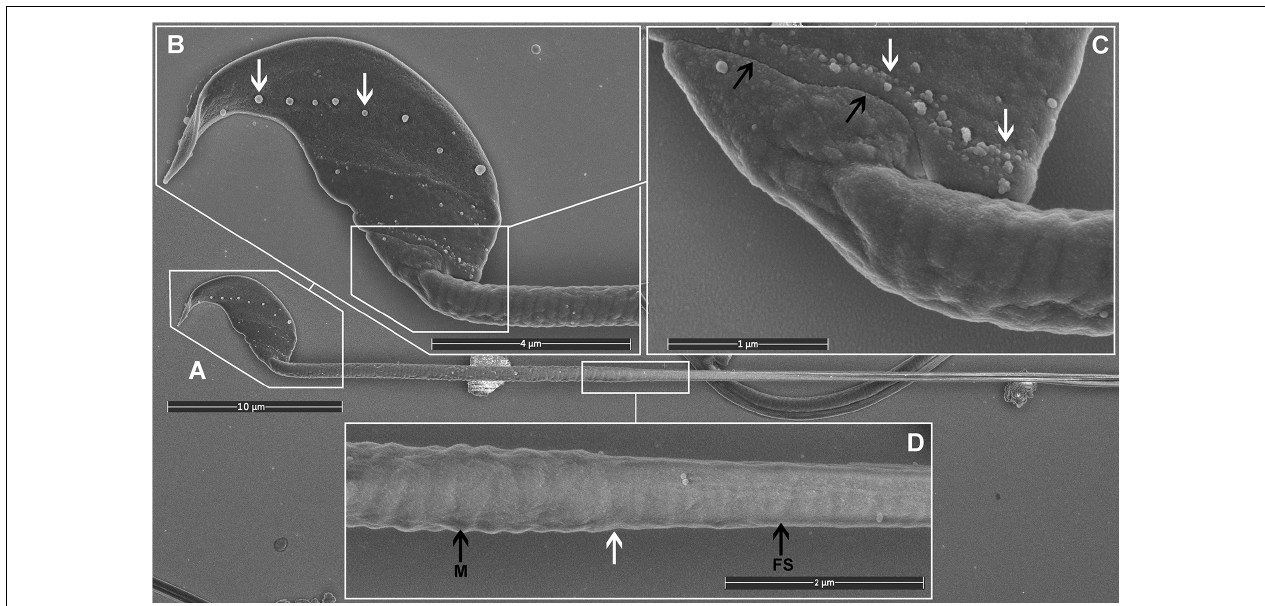
FIGURE 2 | Scanning electron microscopy images of mouse sperm fixed using TAGA. (A) A single sperm at low magnification. (B) The head structure. The arrows mark the presence of exosome-like structures decorating the equatorial region. (C) The sperm head-tail-coupling apparatus (black arrows) where the sperm head is attached to the flagellum. The white arrows mark the presence of a second line of exosome-like structures attached to the plasma membrane. (D) The sperm mid-piece principal piece junction (white arrow). A clear impression of the helically arranged mitochondria (M) is visible on the left, and the fibrous sheath (FS) of the principal piece on the right.